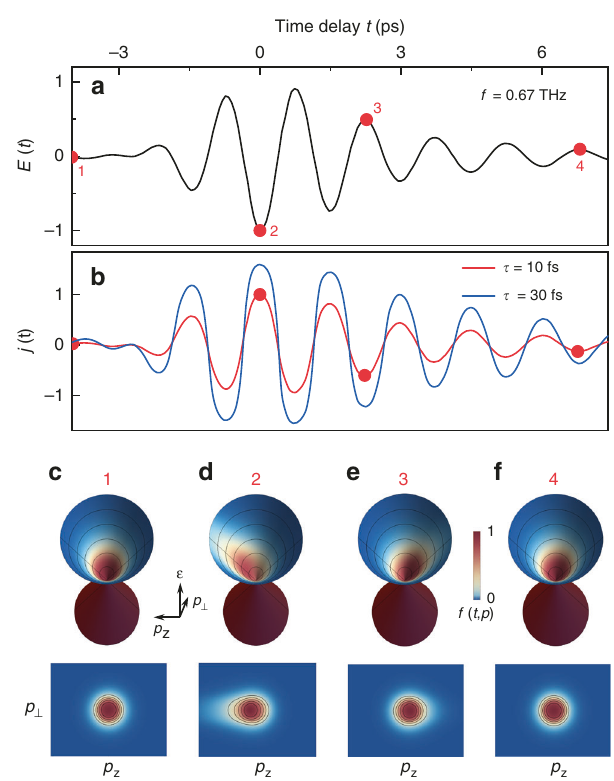
Fig. 2 THz-driven nonlinear kinetics and time-resolved distribution function. a Multicycle pump pulse of f = 0.67 THz characterized in air by its time-dependent electric fi eld E ( t ). b The derived current density j ( t ) by solving the Boltzmann equation for τ = 10 and 30 fs, respectively, for the pump pulse with peak fi eld strength of 110 kV/cm. c – f 3D and 2D illustration of the distribution function f ( t ,p) in the upper band of the Dirac cone, corresponding to τ = 10 fs for various time-delays as marked by the points 1 – 4 in a , b respectively. ε denotes energy. p z denotes momentum component along the linearly-polarized pump-pulse electric fi eld. p ⊥ denotes momentum in the perpendicular direction. See Supplementary Fig. 5 and Supplementary Movies 1 and 2 for more comparisons between τ = 10 and 30